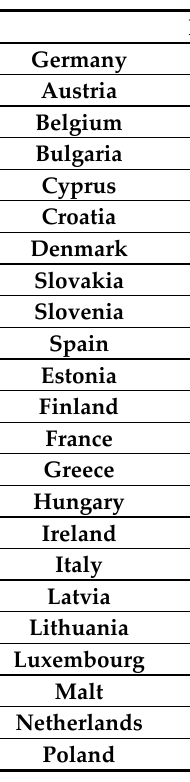
Table 9. Values of average environmental efficiency with Method 2 and with Method 1 for the 28 countries in the period 2005–2012. Source: self